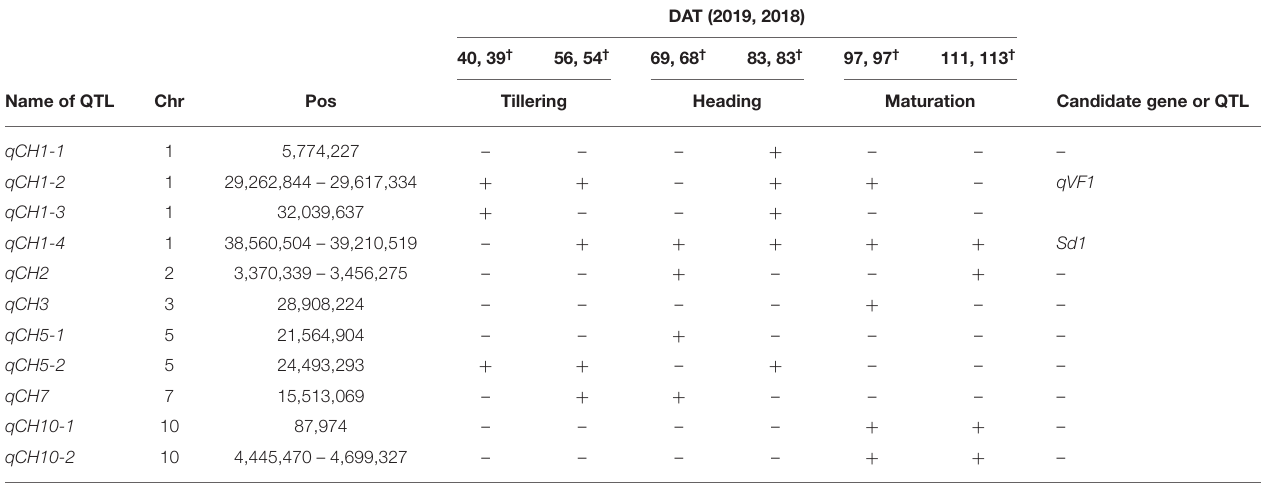
† DATs in 2019 (left) and in 2018 (right) are